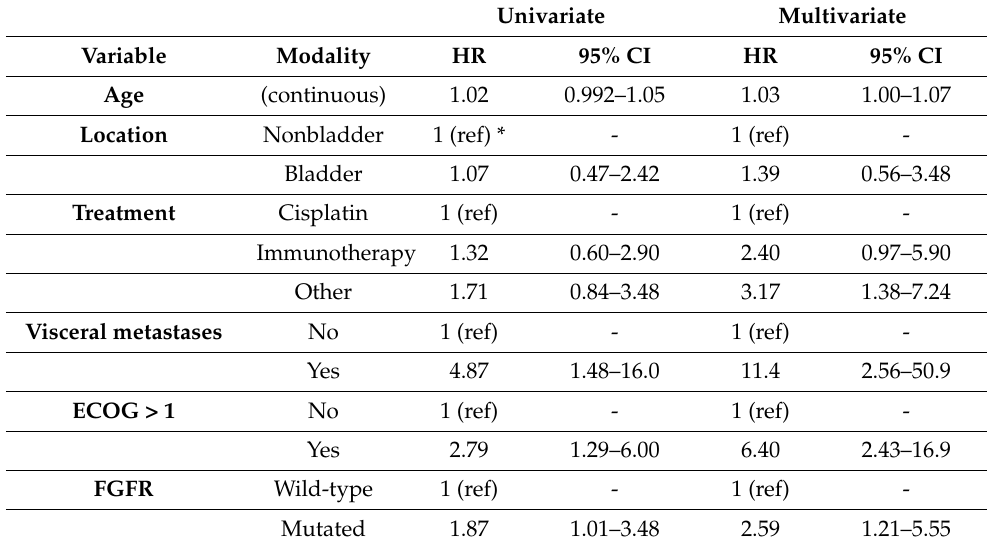
Table 4. Univariate and multivariate analysis for prognostic factors and overall survival. Univariate